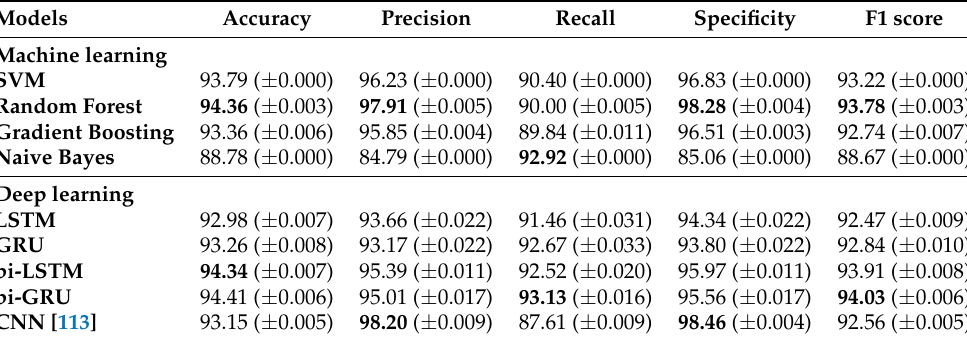
Table 8. Evaluation of proposed models regarding accuracy, precision, recall and F1 score (in % with its respective standard deviation) using raw text of the messages. Please note that Random Forest and naive Bayes presented a very low standard deviation and it is represented as zero.